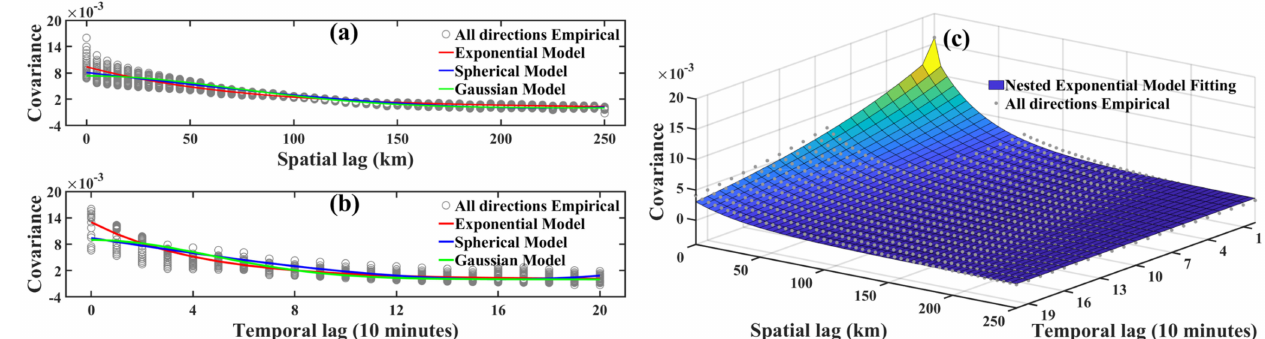
Figure 4. ( a , b ) Experimental (circles) and fitted theoretical (solid line) covariance shown as a function of the spatial lag (0 to 250 km) and the temporal lag, respectively. The exponential model fitting is shown as red solid line, the spherical model fitting is shown as blue solid line, and the green solid line represents the Gaussian model fitting. ( c ) Experimental (gray solid dots) and fitted nested theoretical spatiotemporal covariance (color). The spatial lag (0 to 250 km) is shown on the left axis, and the temporal lag (0 to 200 min) is shown on the right axis and the spatiotemporal covariance on the vertical axis. Experimental covariance is calculated from the point pairs at specific distances according to AOD datasets after spatiotemporal trend removal, which is based on datasets from May